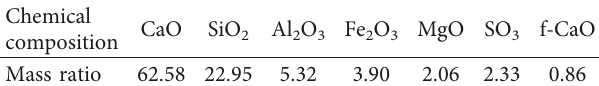
Table 2: Chemical components and mineral composition of or- dinary silicate cement.